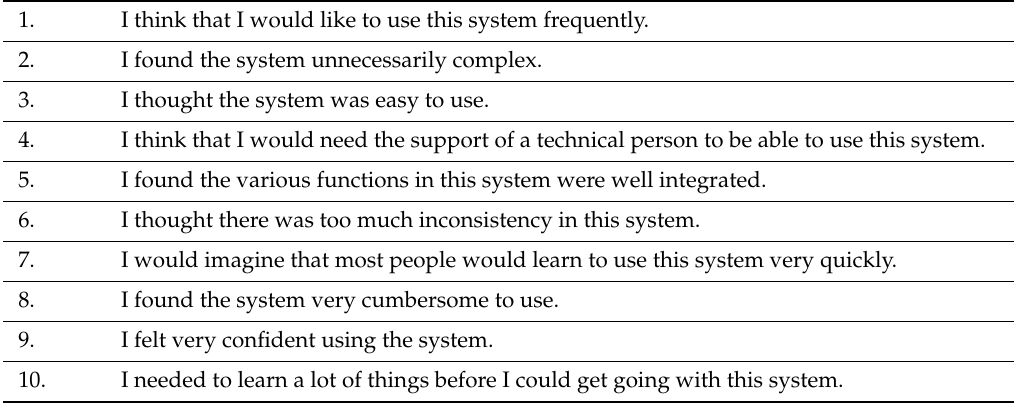
Table 2. System Usability Scale (SUS) questions used in the survey